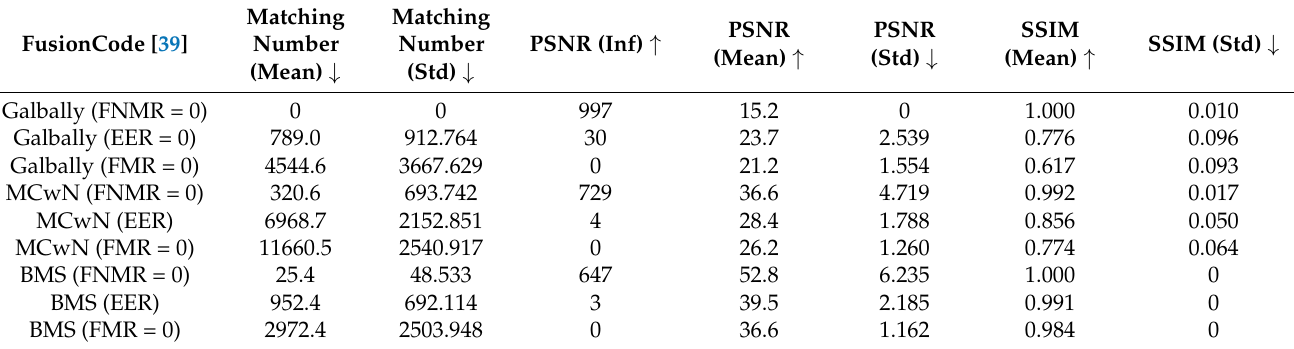
Table 6. Attack performance of FusionCode [39].